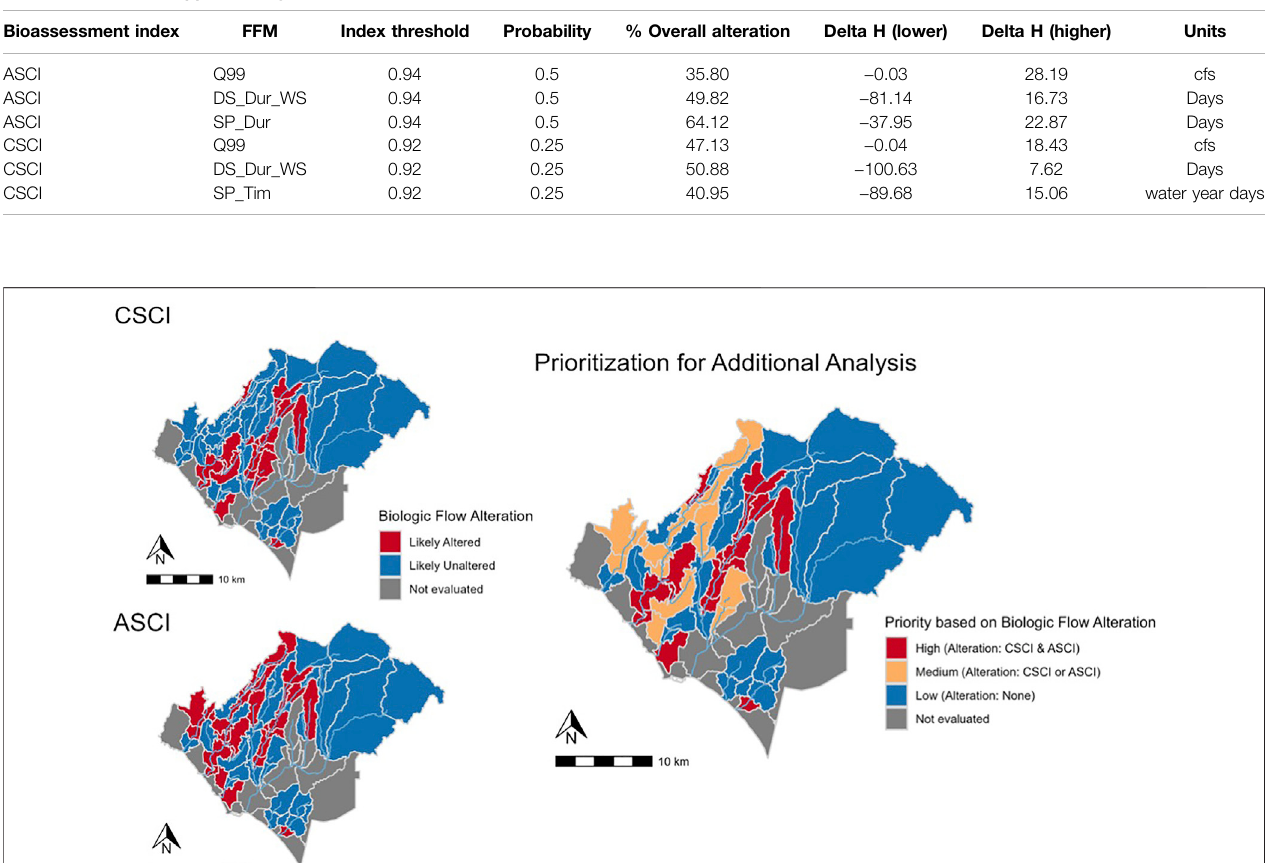
Frontiers in Environmental Science |